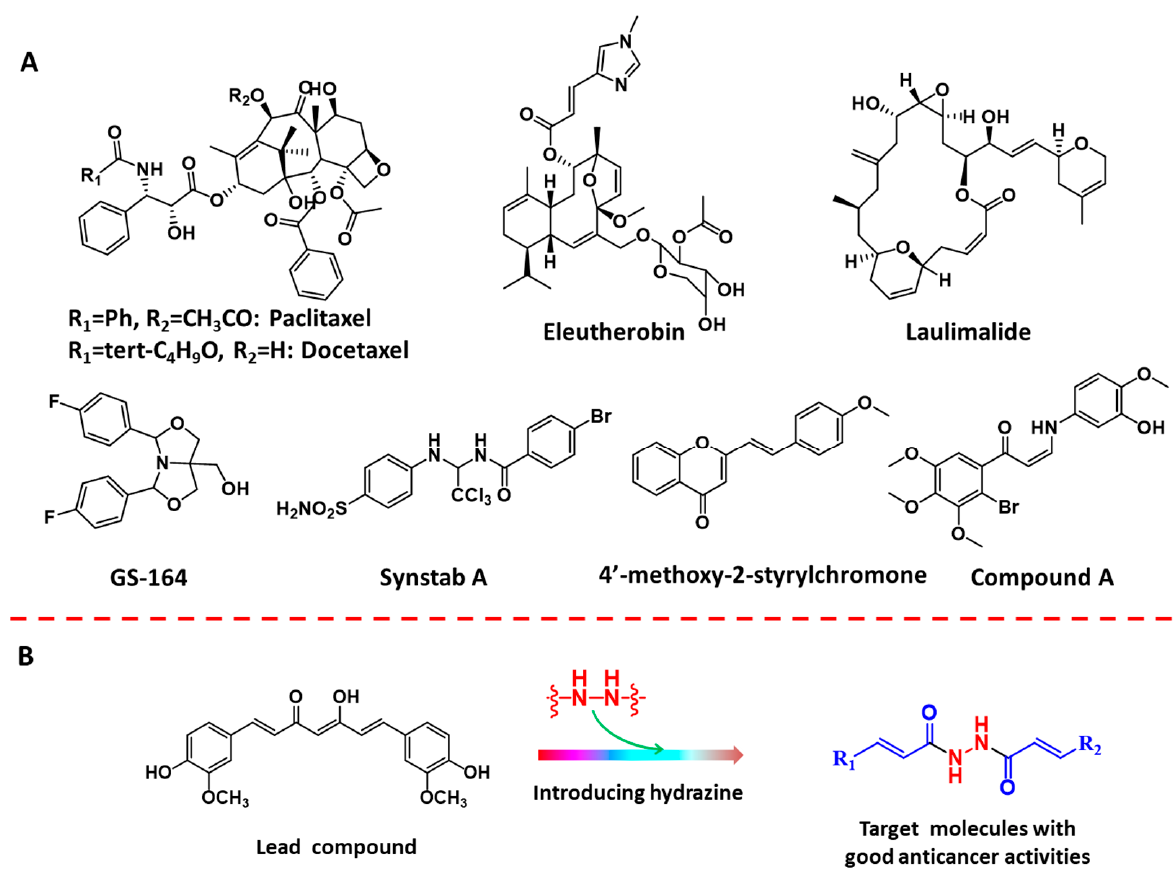
Figure 1. Chemical structures of some microtubule-targeting agents ( A ). Design concepts of target molecules ( B ).